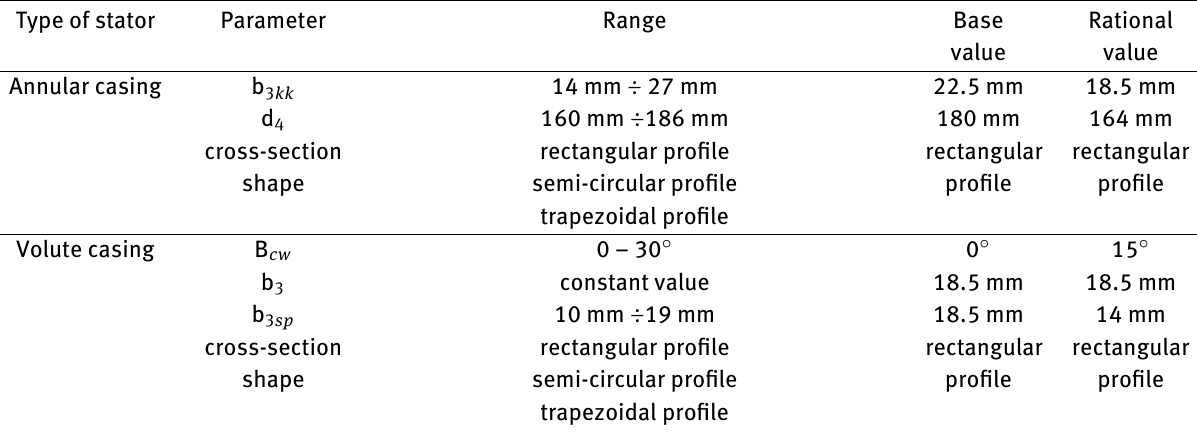
Table 2: Research changes of geometrical parameters of stator type. Type of stator